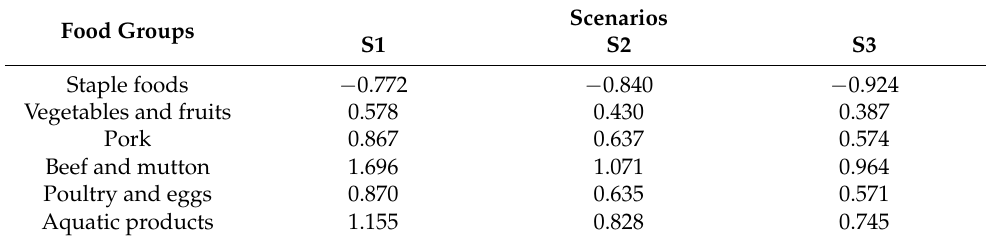
Table 5. Three scenarios regarding income elasticities of individual food groups. Food Groups